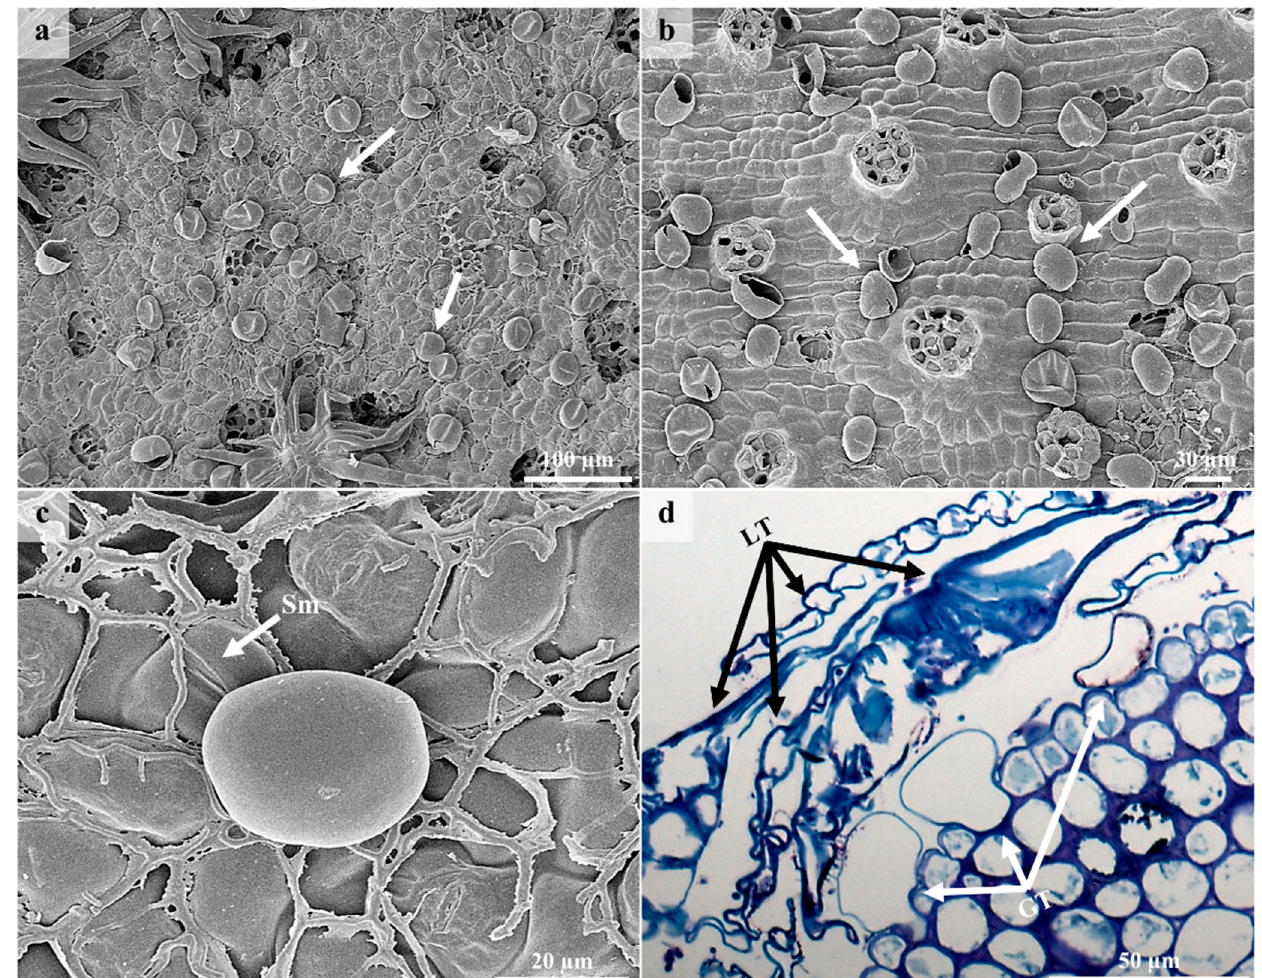
Figure 5. SEM and LM micrographs showing glandular trichomes on the leaves and stems. ( a ) Glan- dular trichomes on abaxial surface of leaves beneath lepidote trichomes. ( b ) Stem showing glandular trichomes after removing lepidote trichomes. ( c ) High magnification of single glandular trichome on abaxial surface of leaf. ( d ) Light micrograph showing unicellular glandular trichomes of different forms canopied by several layers of lepidote trichomes. Sm—Stoma, LT—Lepidote Trichome, GT— Glandular Trichome.